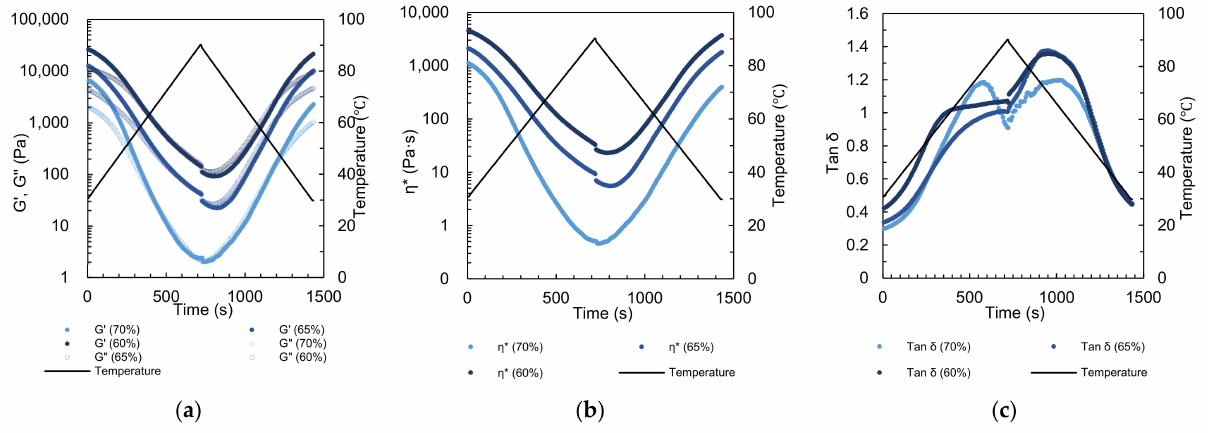
Figure 4. Calcium caseinate premixes at moisture contents of 60%, 65%, and 70% during temperature sweep experiments: ( a ) storage modulus (G (cid:48) ) and loss modulus (G (cid:48)(cid:48) ), ( b ) complex viscosity ( η *), and ( c ) loss factor (tan δ